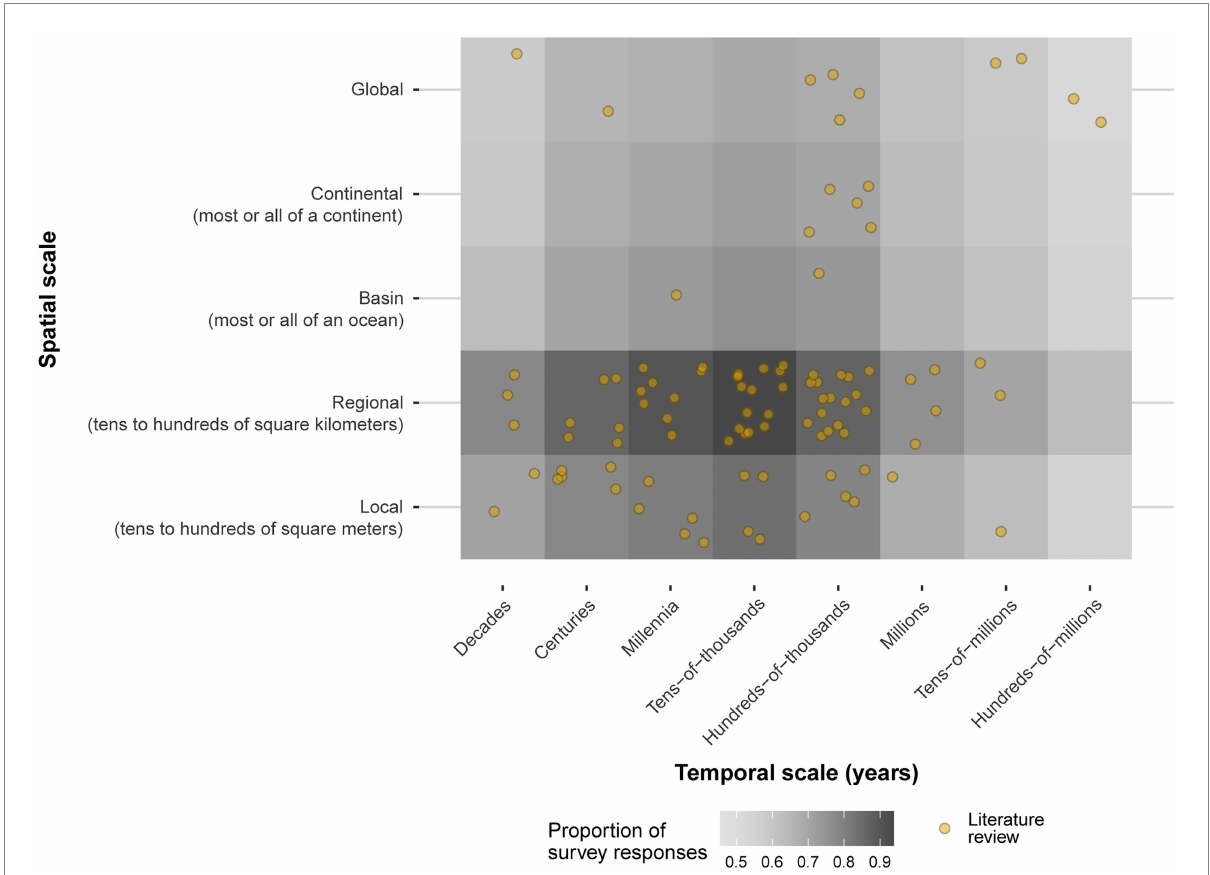
FIGURE 6 Comparison of the expected versus published spatial and temporal scales of CPB research. To assess expectations, we asked survey participants which scales they consider to be most relevant to CPB. To summarize published research, we recorded the scales of publications in the literature review. Similar coding criteria were used to ensure compatibility across the survey responses and literature review. Near-time records collected over local to regional scales overwhelmingly characterized CPB research despite a widespread perception that the field can encompass all time periods and spatial scales (i.e., no combination of spatial and temporal scales was selected by fewer than 45% of respondents to both questions). Note that the literature review data points are jittered to prevent complete overlap; there is no higher resolution implied beyond the categories listed in the X - and Y